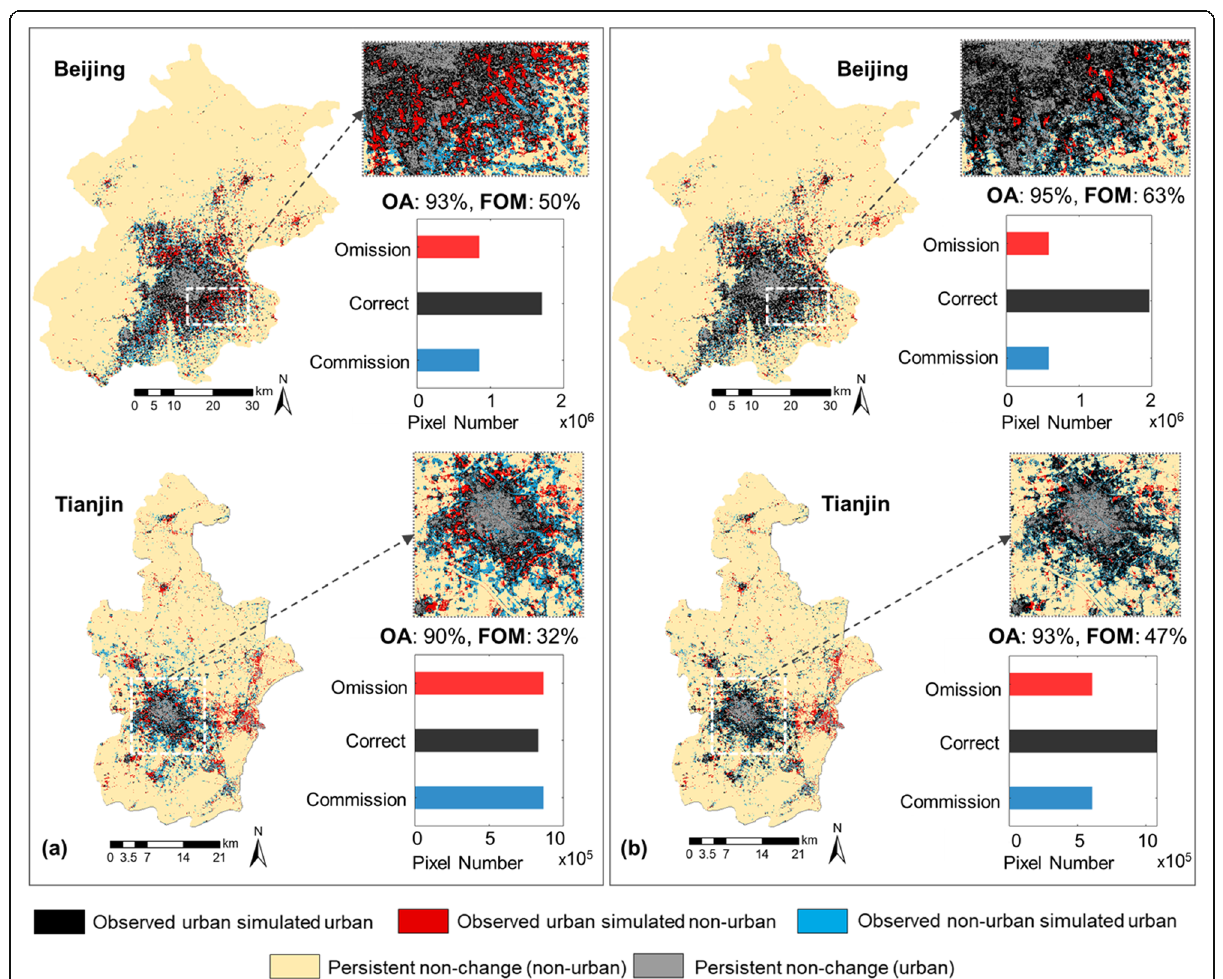
Fig. 6 Comparison of the urban sprawl modeling during 1985 – 2015 using the traditional Logistic-CA ( a ) and the Logistic-Trend-CA ( b ) in Beijing and Tianjin at a 30-m spatial